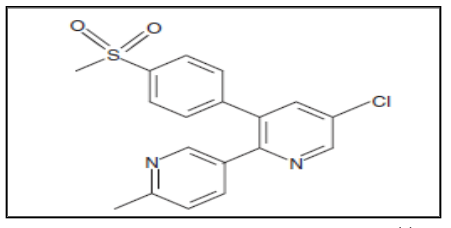
Figure 1.Structural formula of EXB (5)